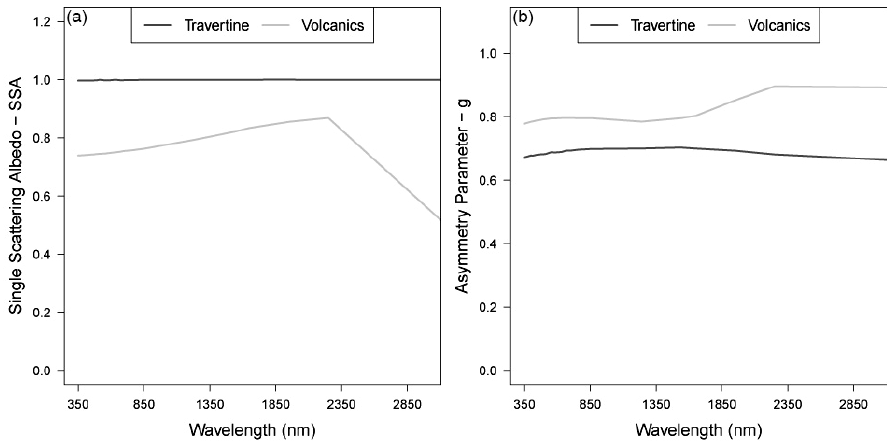
Figure 7. Single scattering albedo (a) and asymmetry parameter (b) of the volcanics and travertine PM 10